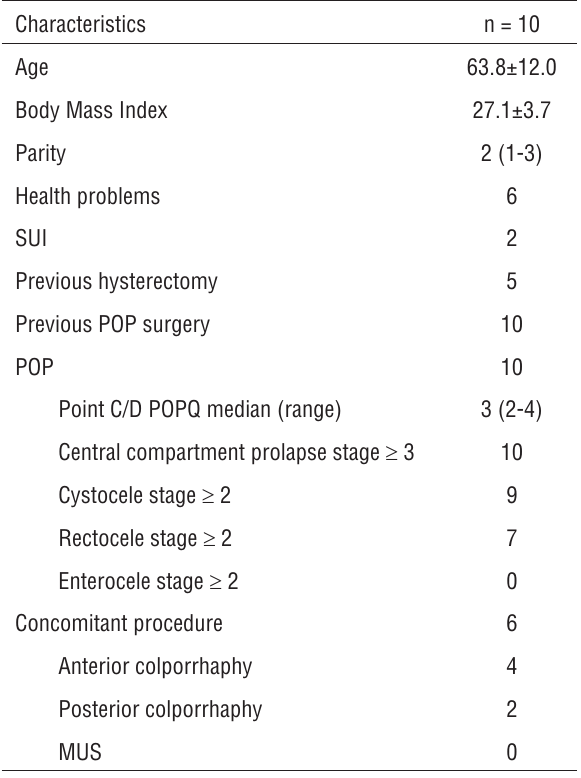
Table 2 - Preoperative demographic and clinical characteristics of 10 patients who underwent neuGuide™